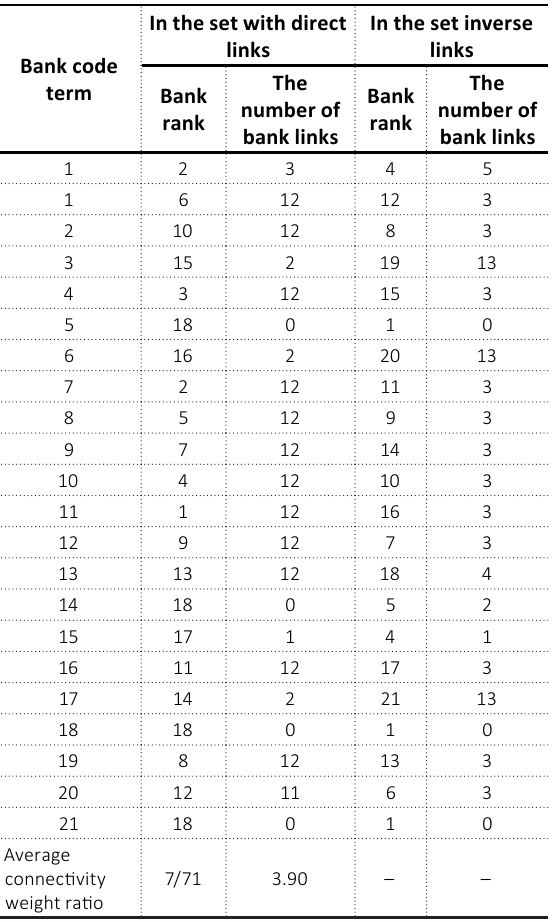
Table 3. Ranks of bank connectivity ratios and number of bank direct and inverse links